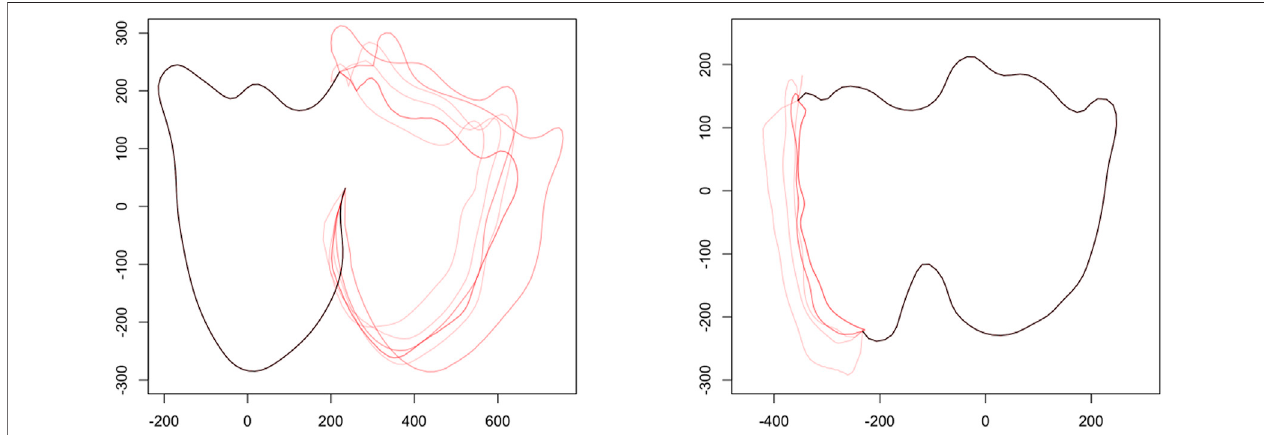
FIGURE 3 | Examples of partial matches followed by imputation on partially observed teeth . Left: Approximately 50% of the tooth is observed. Right: Approximately80%ofthetoothisobserved.Theblackcurvedenotesthefullyobservedportionofthetoothwitheachredcurvebeingasinglecompletionofthetooth.In both examples shown here M (cid:2) 10 and K (cid:2)